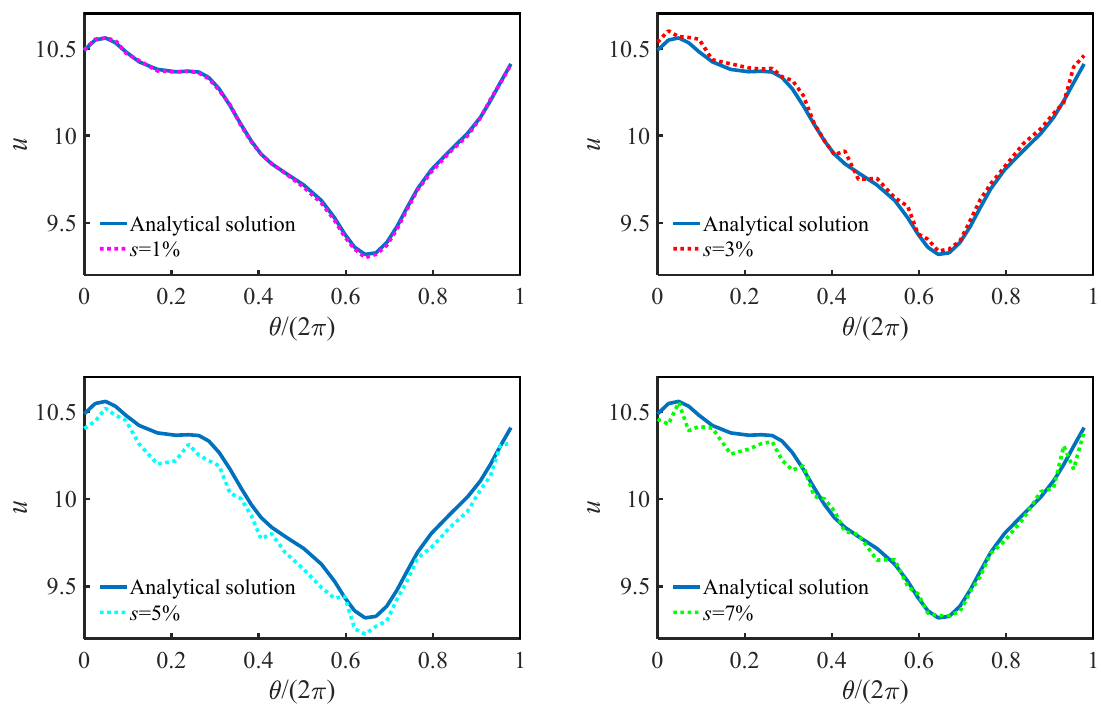
Figure 11. Comparisons between the numerical and analytical solutions on boundary Γ 2 .